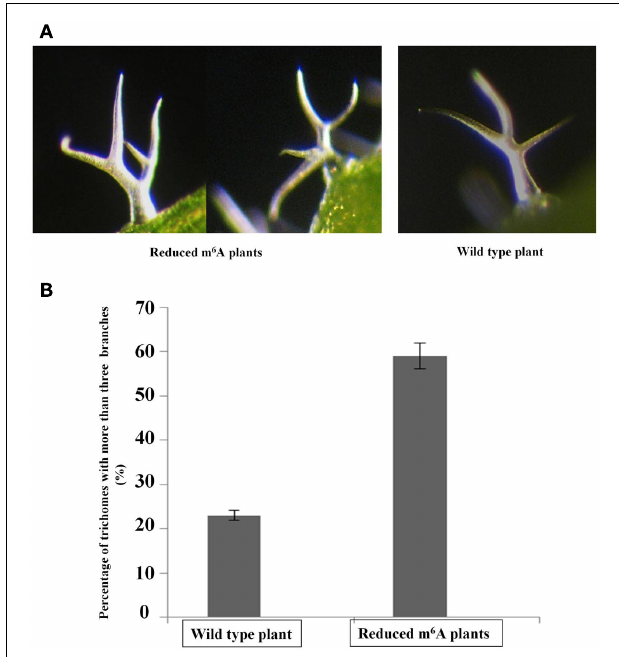
FIGURE 3 |Altered levels of trichome branching in 3-week-old seedlings. The third and fourth leaves from 3-weeks-old seedlings of wild type and homozygous SALK_074069 ABI3MTA plants were examined for changes in their trichome phenotypes. Light micrographs of trichomes from plants with low m6A levels and from wild type plants (A) .The low m6A plants are characterized by a higher proportion of trichomes with four or more branches.Trichomes from the abaxial side were analyzed for the third and fourth leaves from four wild type and four low m6A plants, each from different transgenic lines (554 and 521 trichomes respectively). Sixty-three percentage of trichomes from low methylation plants had four or more branches compared to just 24% in wild type (B) . Error bars represent SD of the replicates.